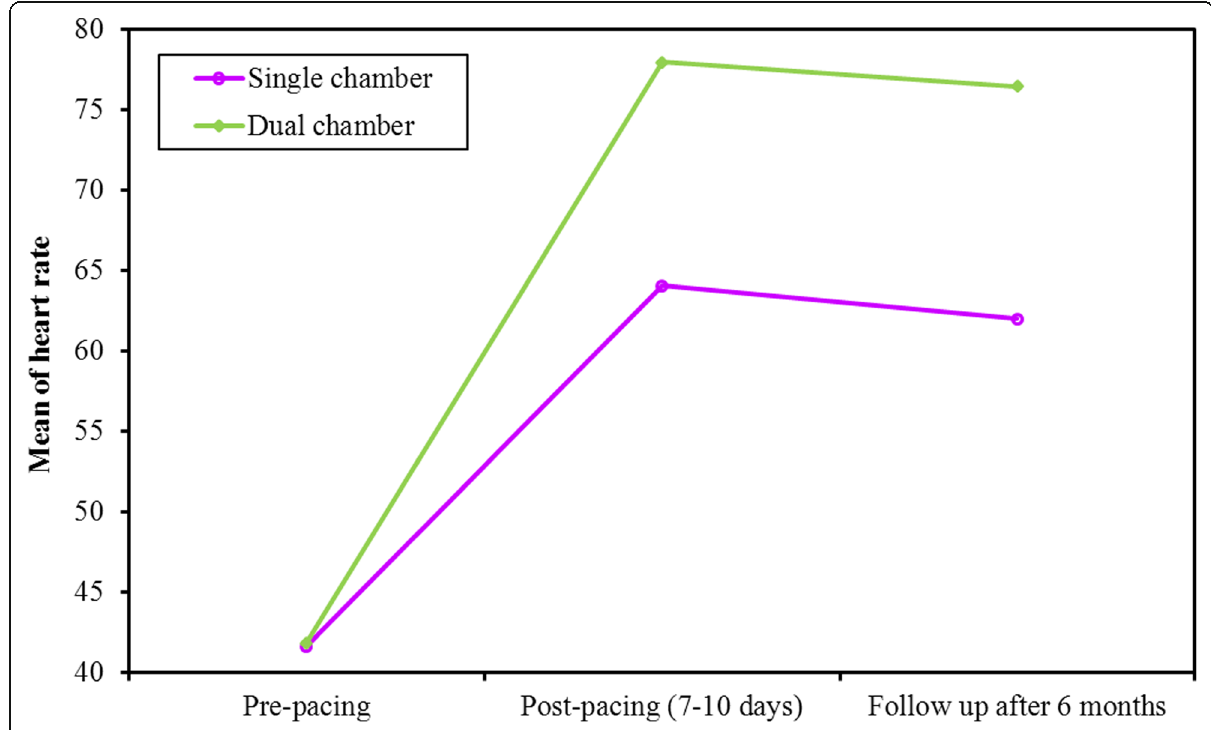
Fig. 1 Comparison between the different periods according to heart rate in each